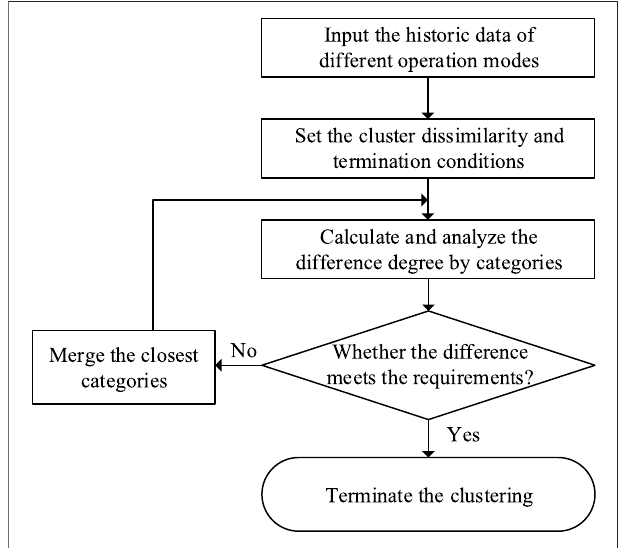
FIGURE 1 | Flowchart of the data-driven clustering